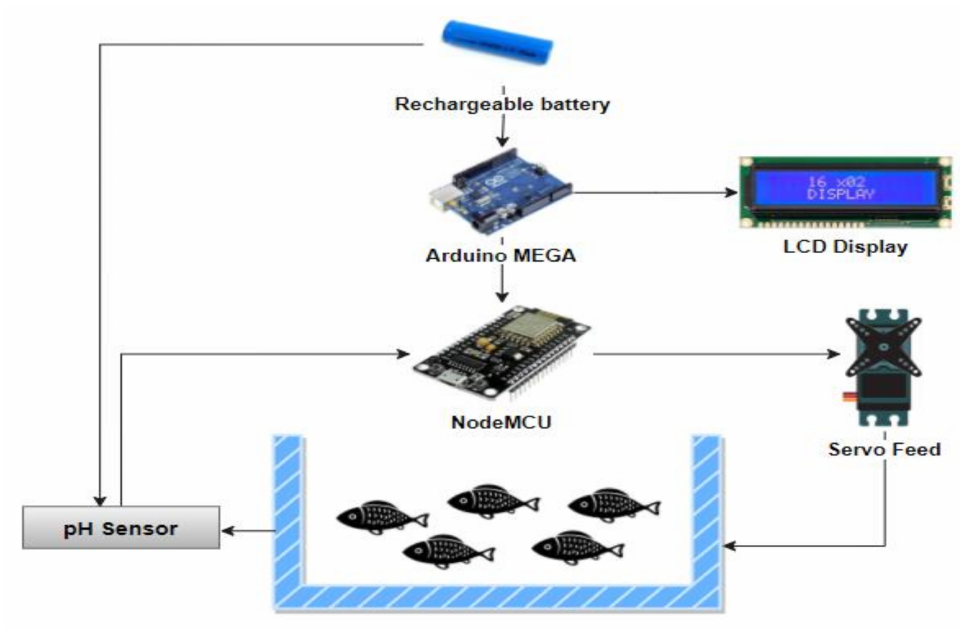
Figure 5. Block diagram complete system of IoT application.